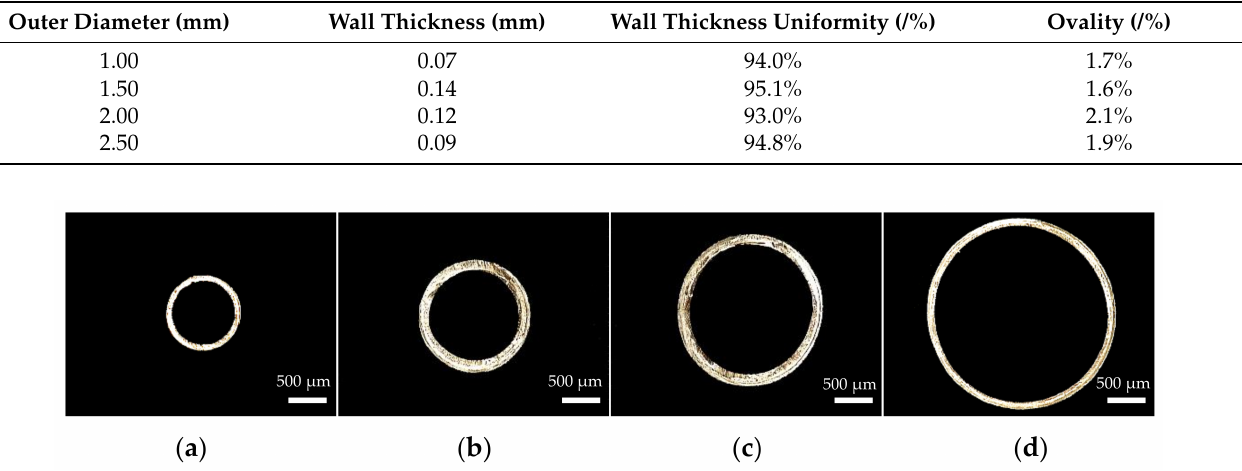
Table 3. Dimensions and shape accuracy of processed micro tubes.